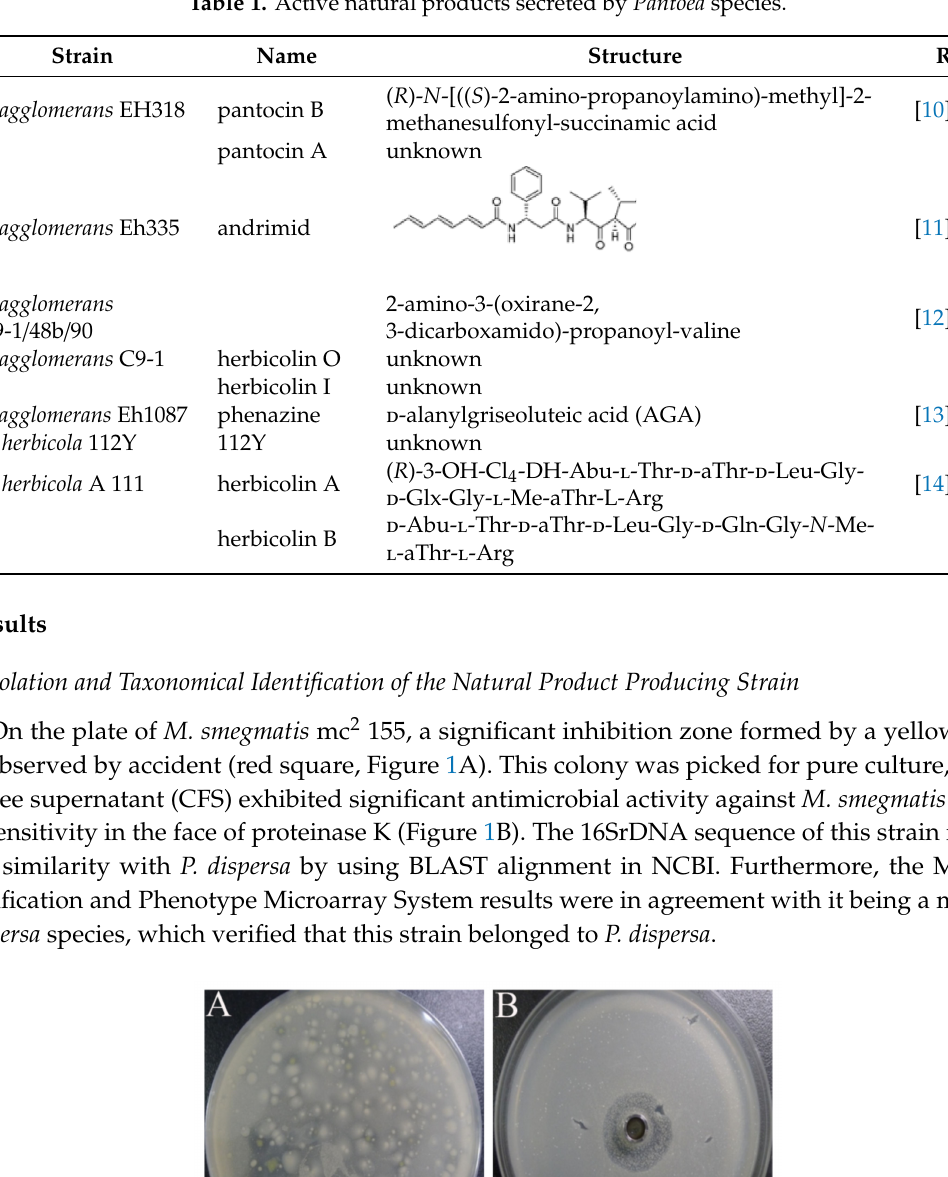
Table 1. Active natural products secreted by Pantoea